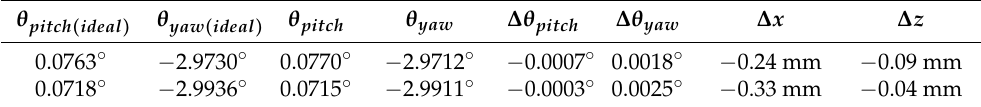
Table 5. The attitude errors.